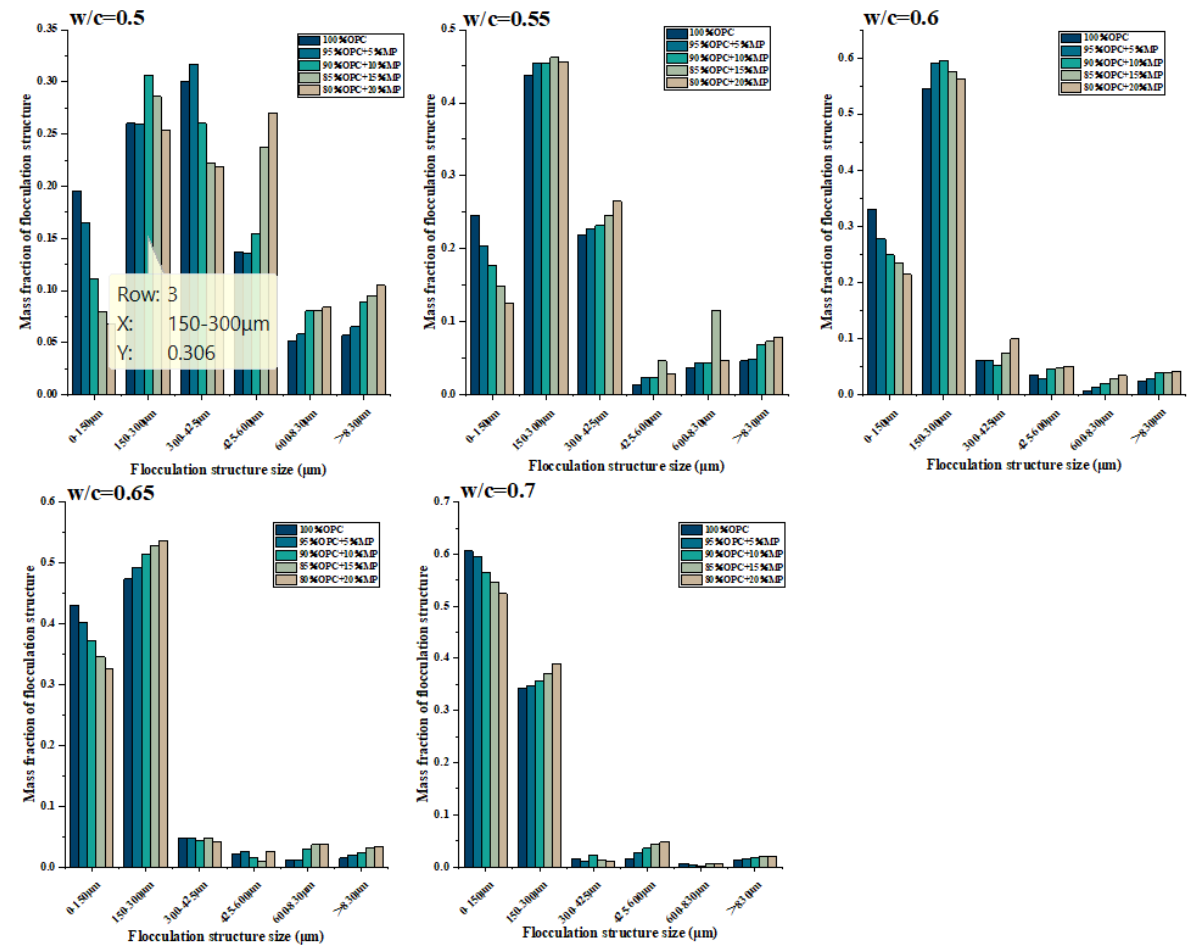
Figure 8. Differentiation of flocculent structure size with W/CM at different MP contents. Table 4. Variation of flocculation structure mass fraction with W/CM at different MP